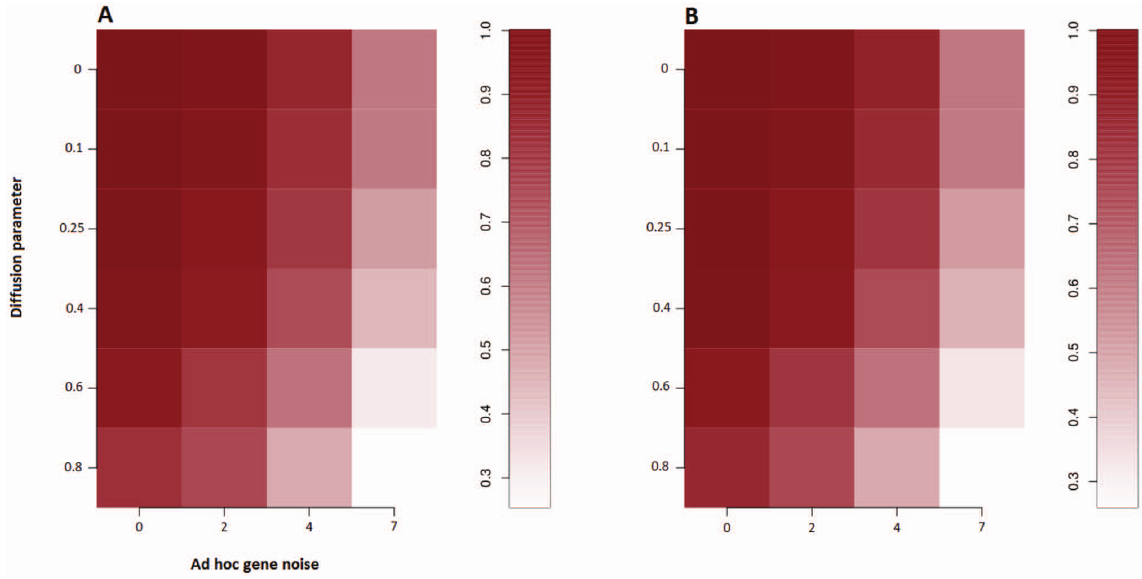
Figure 3. Robustness to expression noise. (A) Sensitivity and (B) precision of the method in predicting the gene-expression-driving miRNAs when varying the level of gene-interactions noise (via the diffusion parameter d ) and the intensity of the noise in the differential gene expression level (via the variable k ). All predicted miRNAs have the correct influence signs.